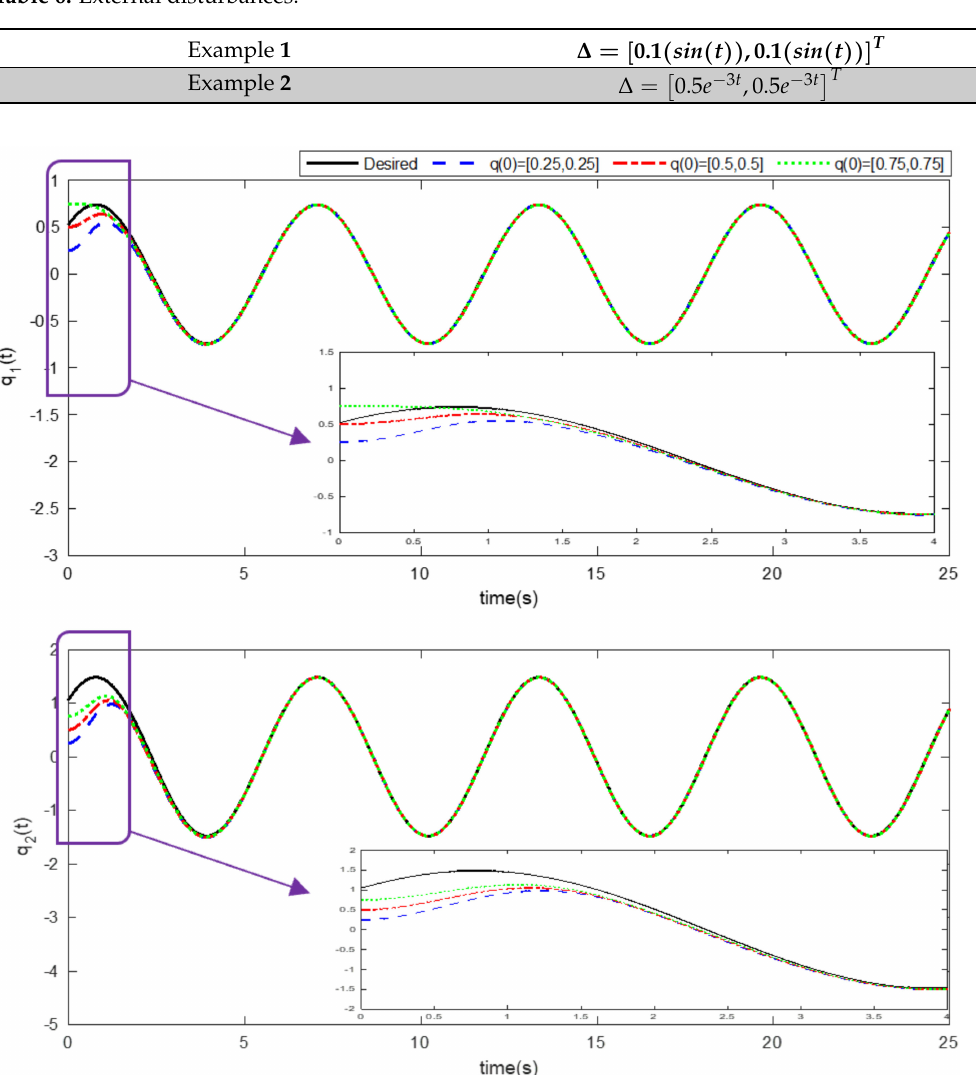
Figure 4. Desired tracking of the exoskeleton robot system (Example